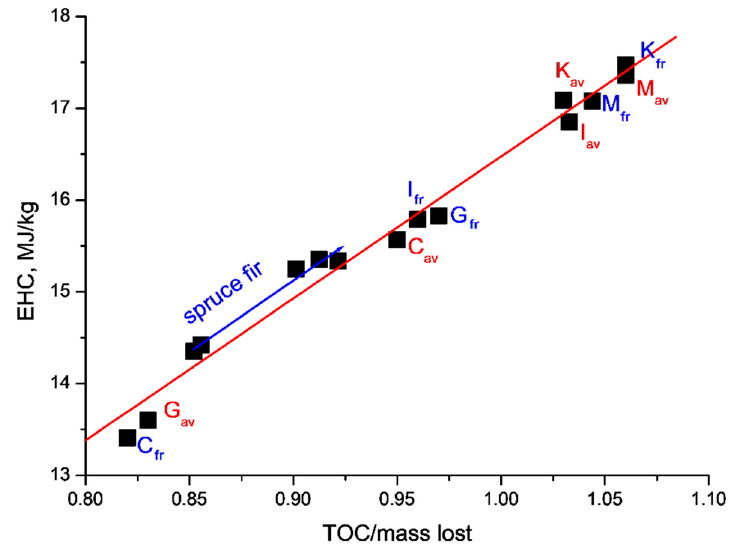
Figure 10. Universal correlation between e ff ective heat consumption (EHC) and total oxygen consumed related to unity of mass lost during burning.